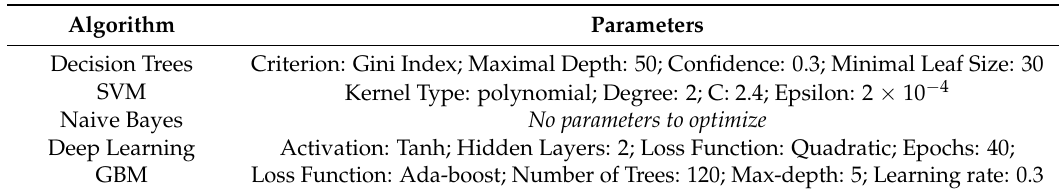
Table 7. Parameter values, upon completion of the parameter tuning process for Experiment